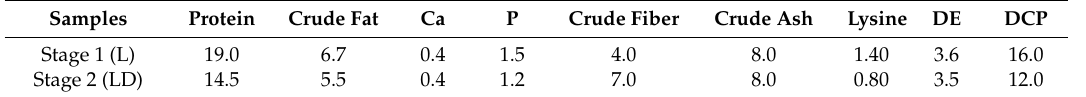
Table 1. Feed composition for stage 1 (10 weeks) and stage 2 (26 weeks), Ca: Calcium, P: Phosphorus, DE: Digestible energy, DCP: Digestible crude